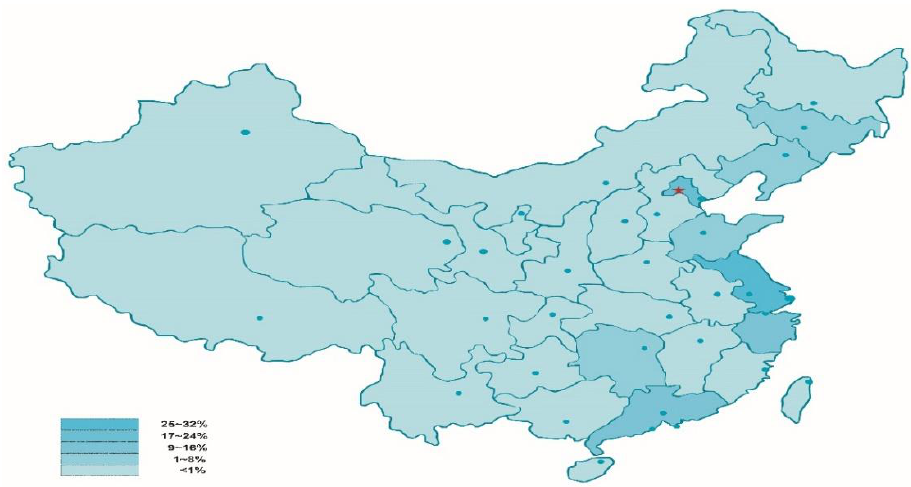
Figure 7. Distribution of the patents in China.